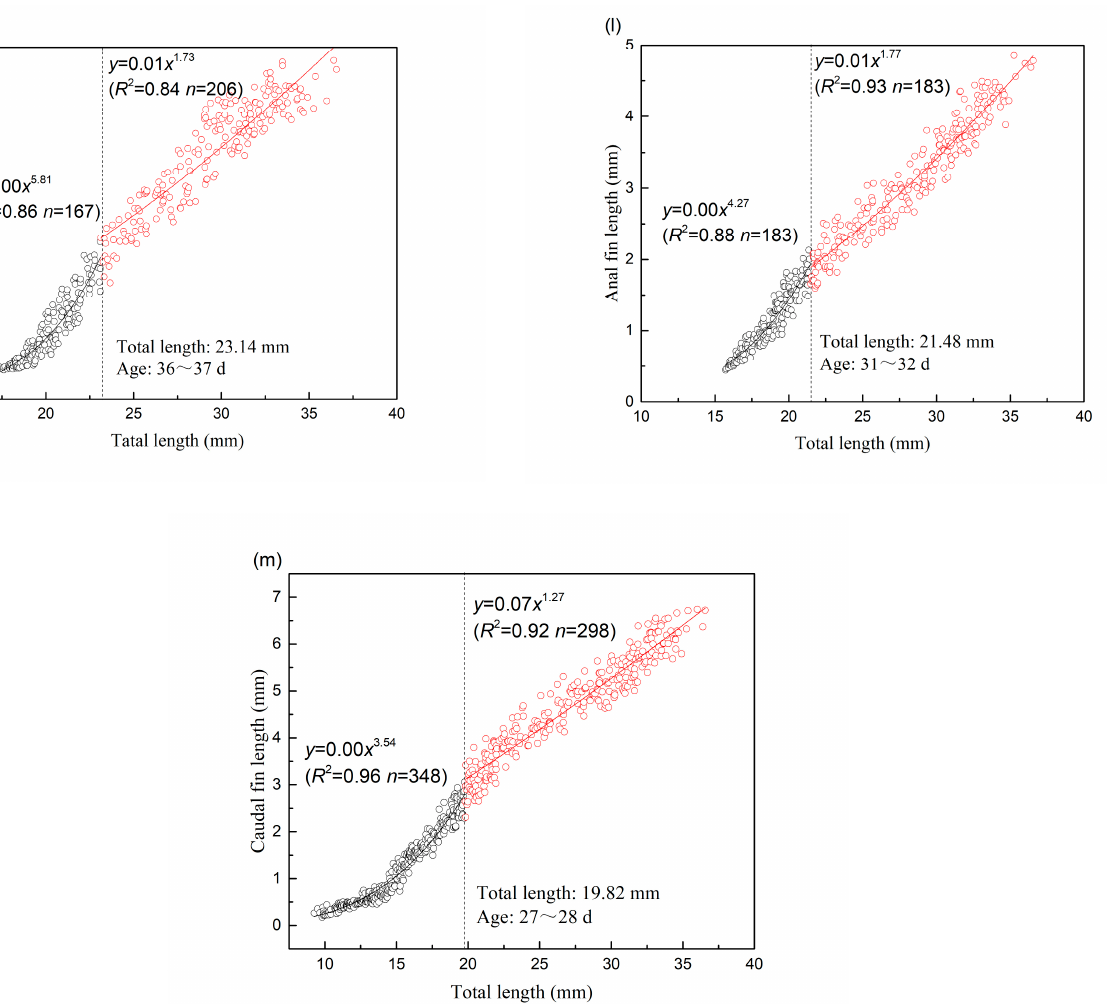
Figure 9. Allometric growth curve and equations of P. retrodorslis during larval and juvenile periods. ( a ) Head length; ( b ) Trunk length; ( c ) Tail length; ( d ) Head depth; ( e ) Body depth; ( f ) Body depth at anus level; ( g ) Snout length; ( h ) Eye diameter; ( i ) Pectoral length; ( j ) Dorsal fin length; ( k ) Ventral fin length; ( l ) Anal fin length; ( m ) Caudal fin length. The line of dashes represents the body length and age of the inflection point.